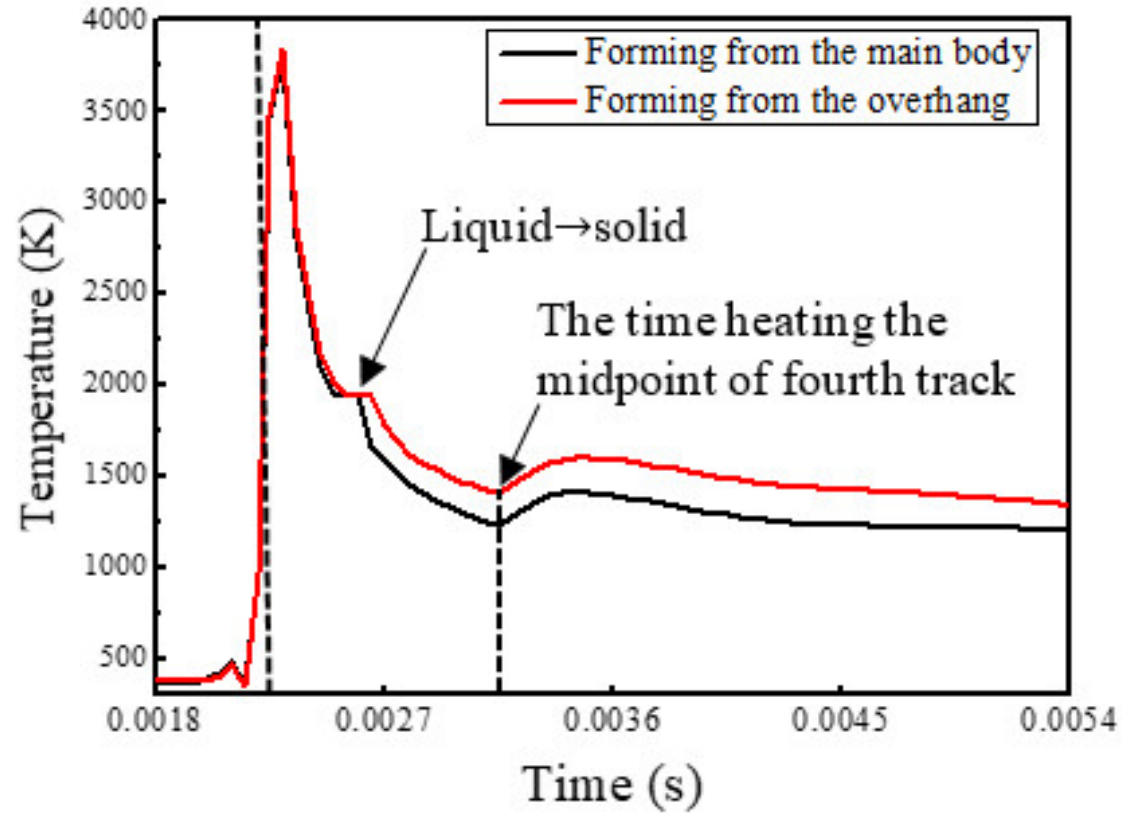
Figure 3. Temperature variations with time at the midpoints of both track 3. Figure 3 shows the temperature histories of the midpoints of both track